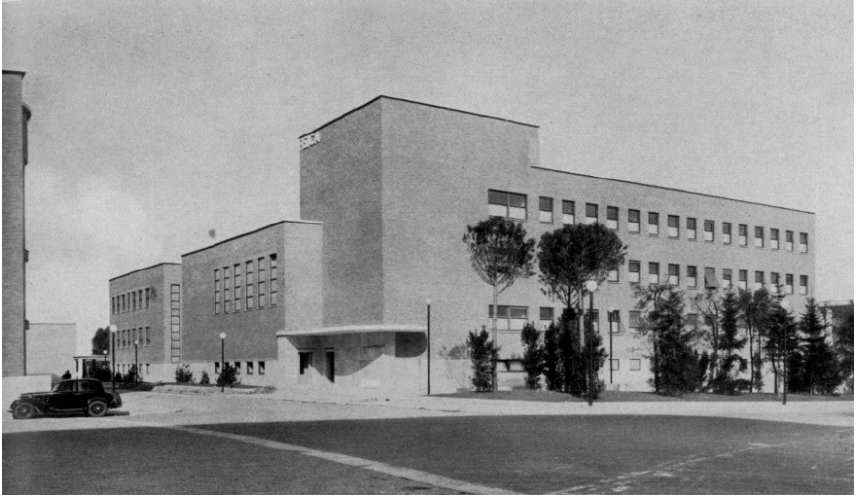
Figure 36. A corner view of the complex. Photo from (De Smaele 1936, p. 10).